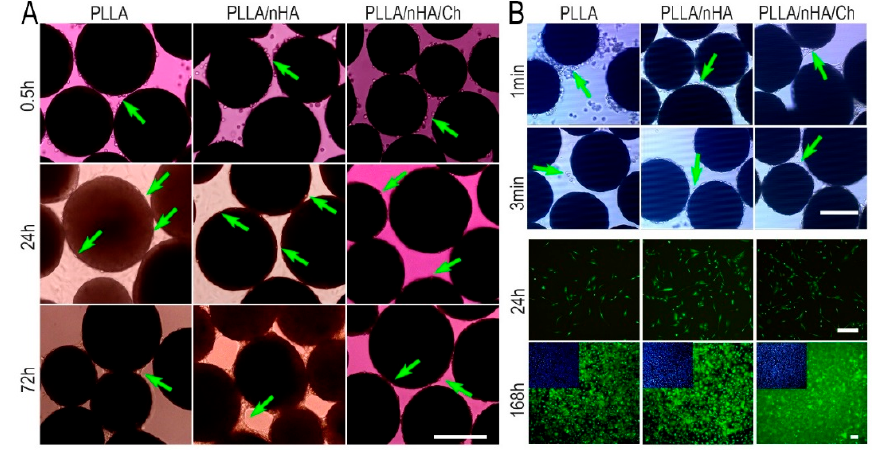
Figure 8. ( A ) The time-course of adhesion and spread of MC3T3-E1 cells of P7 passage on the surface of the three microcarriers with the inoculation density of 1 × 10 5 cells/mL containing the stages of contact, adhesion, spreading, and proliferation; ( B ) The detachment process of MC3T3-E1 from microcarriers and live/dead staining of the detached cells which were reseeded into 24-well plates and cultured for one week. Scale: 250 μ m.